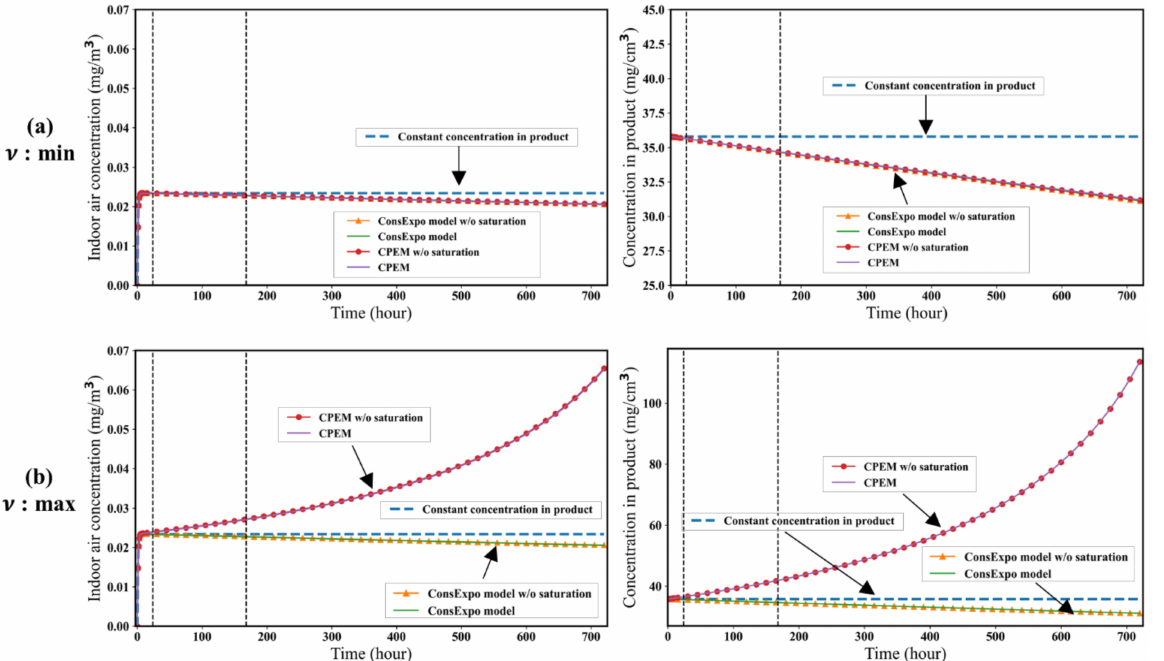
Figure 3. Comparison of the five models in the case where K and S are maximum. The figures on the left show the indoor air concentration of the target substance, and the figures on the right show the substance concentration in the product. Dotted lines correspond to 1 day and 1 week, respectively. ( a ) ν is minimum value in Table 2. ( b ) ν is maximum value in Table